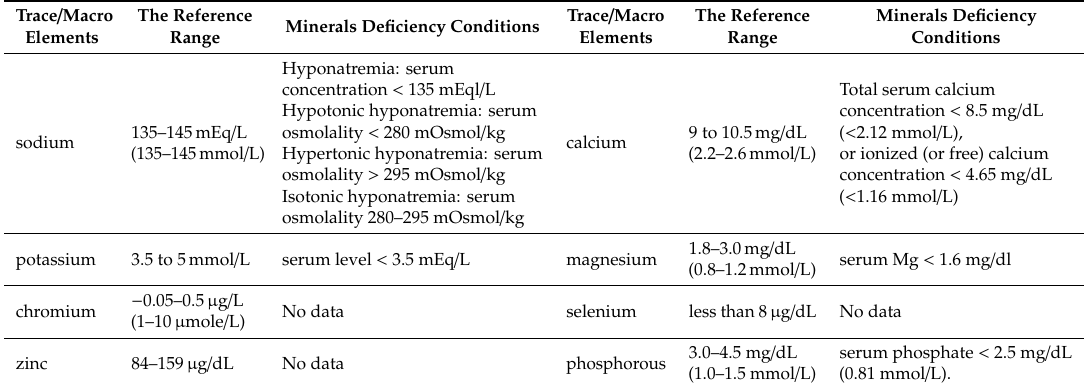
Table 3. The normal range, and deficiency conditions of trace / macroelements in the serum of adults